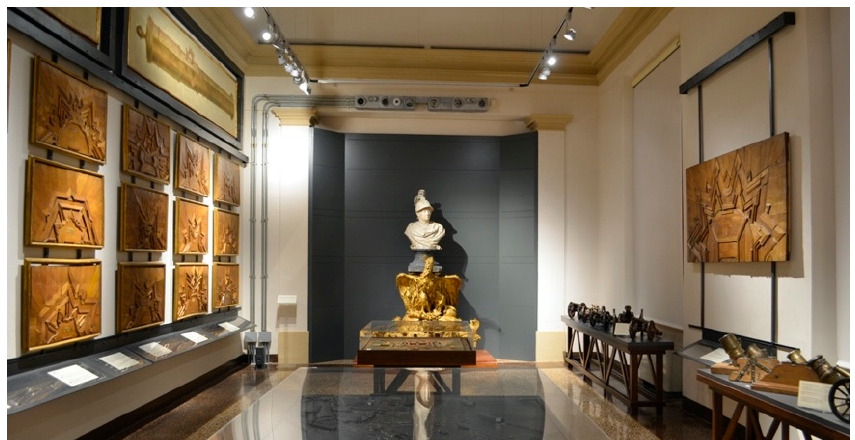
Figure 18. Palazzo Poggi Museum: the Marsili bust in the Military Architecture hall.